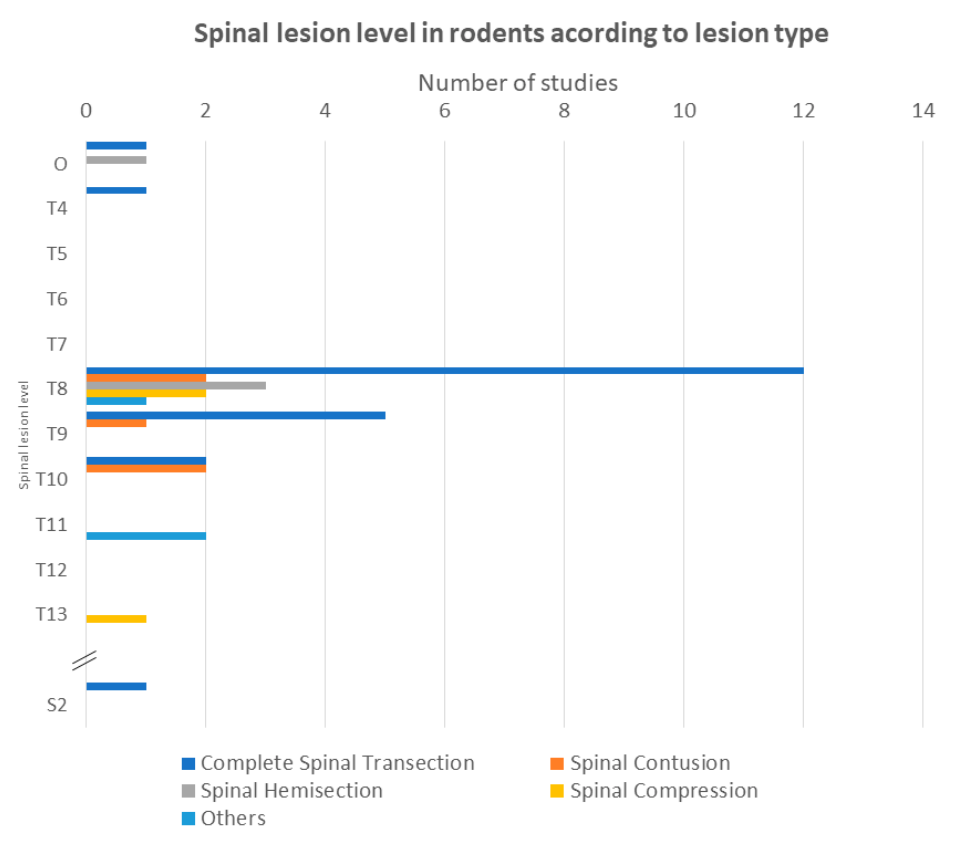
Figure 3. Injured spinal cord levels according to lesion type. O: Other—this category includes one publication which did not specify the spinal lesion level and another study that reported a complex spinal cord injury (involving non-contiguous spinal segments). Since many studies present their spinal lesion level as a combined lesion of two contiguous segments (e.g., T8–T9), we only considered the upper segment in order to graphically represent these data. This graph only represents data reported from rodents (rats and mice) due to their similar vertebral formula. Only two studies used non-rodent animals to induce SCI, and both relied on lagomorphs (rabbits)—which have a distinct vertebral formula.